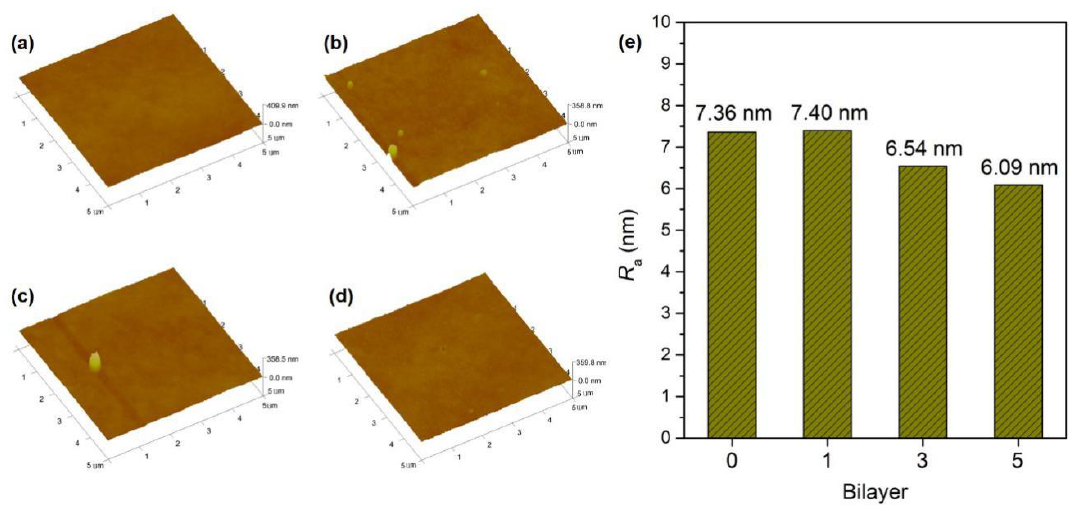
Figure 6. AFM images of PSf ( a ), PSf-1BL ( b ), PSf-3BL ( c ), and PSf-5BL ( d ) membranes, and ( e ) the corresponding R a of membranes with different bilayer numbers.